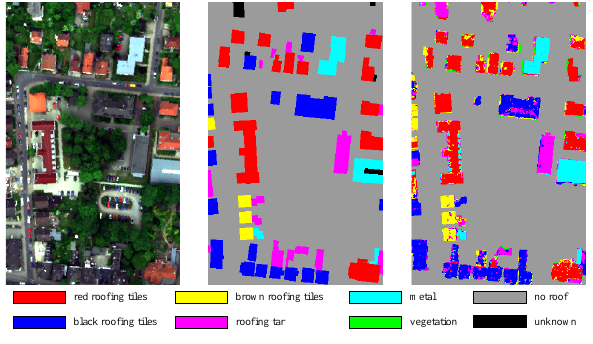
Figure 8: Preliminary classification example; left: AISA+ RGB image, middle: generalized reference image, right: SVM classification result using masked by the eCognition roof